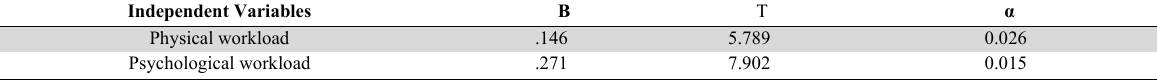
Results of Multiple Regression Analysis between Workload and Organization Commitment Independent Variables